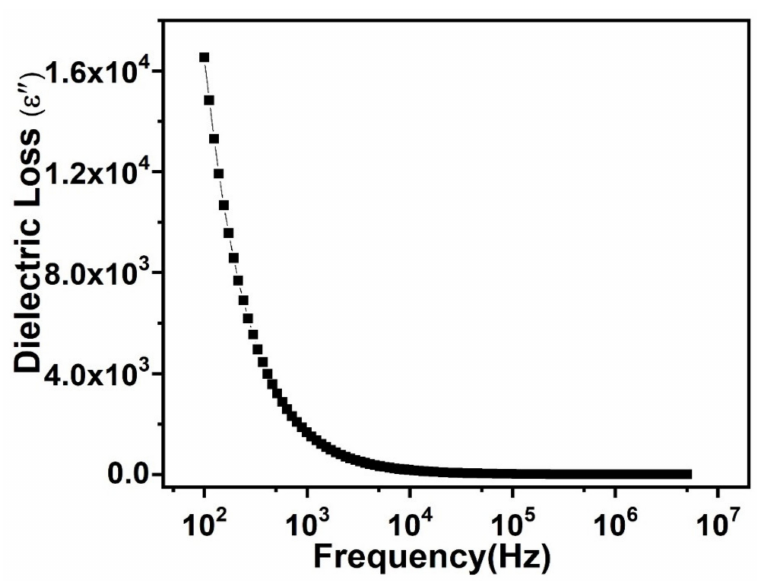
Figure 6. Dielectric loss of prepared PbSe as a function of